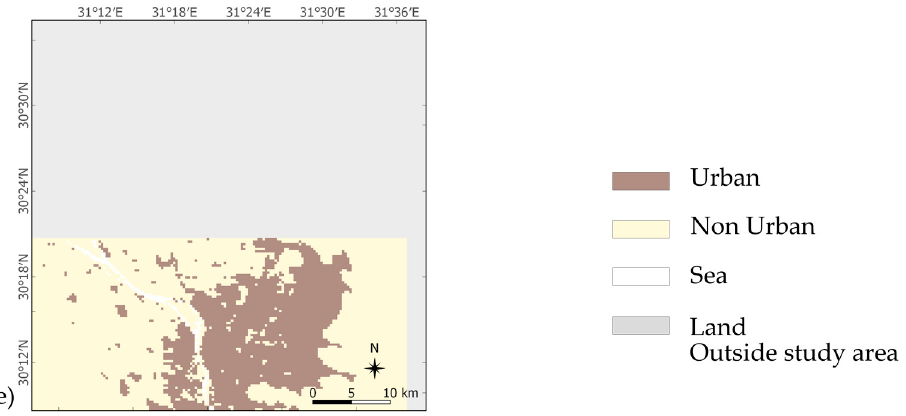
Figure 2. Land cover maps depicting the urban and suburban areas of each study area: ( a ) Athens, ( b ) Marseille, ( c ) Barcelona, ( d ) Rome and ( e ) Cairo.